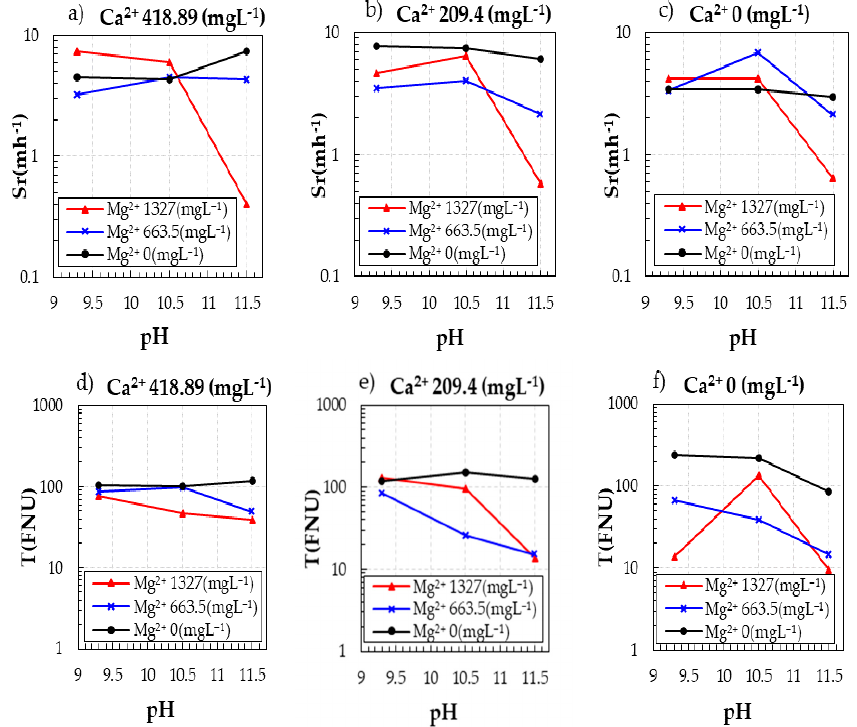
Figure 4. Trends of settling rate (Sr) and turbidity (T) by varying Ca 2+ and Mg 2+ concentrations as well as pH. ( a ) Sr at 418 mg·L − 1 of Ca 2+ , ( b ) Sr at 209.4 mg·L − 1 of Ca 2+ , (c ) Sr at 0 mg·L − 1 of Ca 2+ , ( d ) T at 418 mg·L − 1 of Ca 2+ , (e ) T at 209.4 mg·L − 1 of Ca 2+ , ( f ) T at 0 mg·L − 1 of Ca 2+ . Minerals 2020 , 10 , x FOR PEER REVIEW